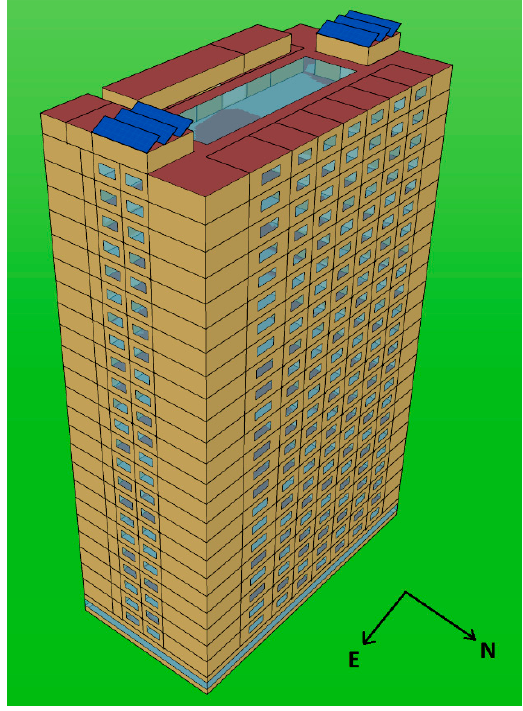
Figure 2. Energy simulation model of a hotel building.